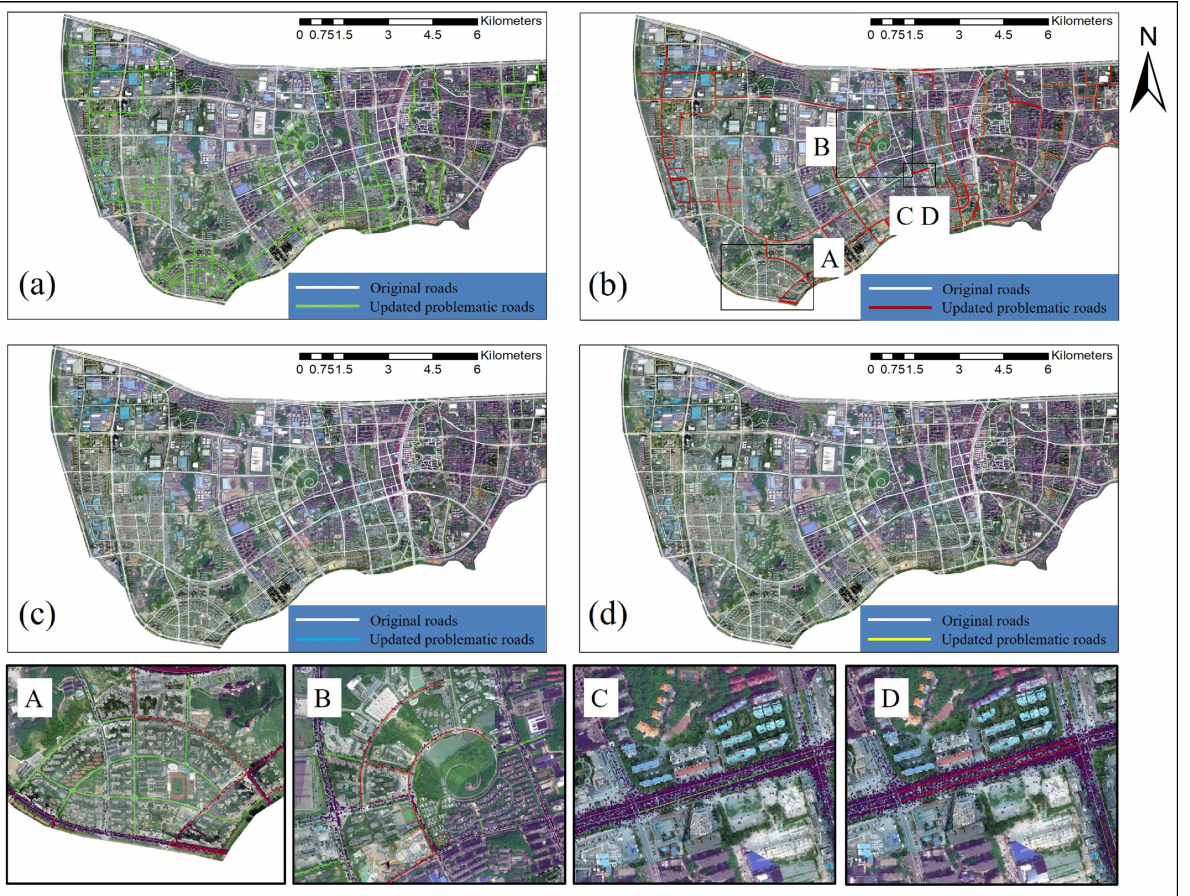
Figure 13. Updated results of the problematic road segments: ( a ) existing problematic road segments; ( b ) results of our method; ( c ) results of Deng et al.’s method (buffer size = 30 m); and ( d ) results